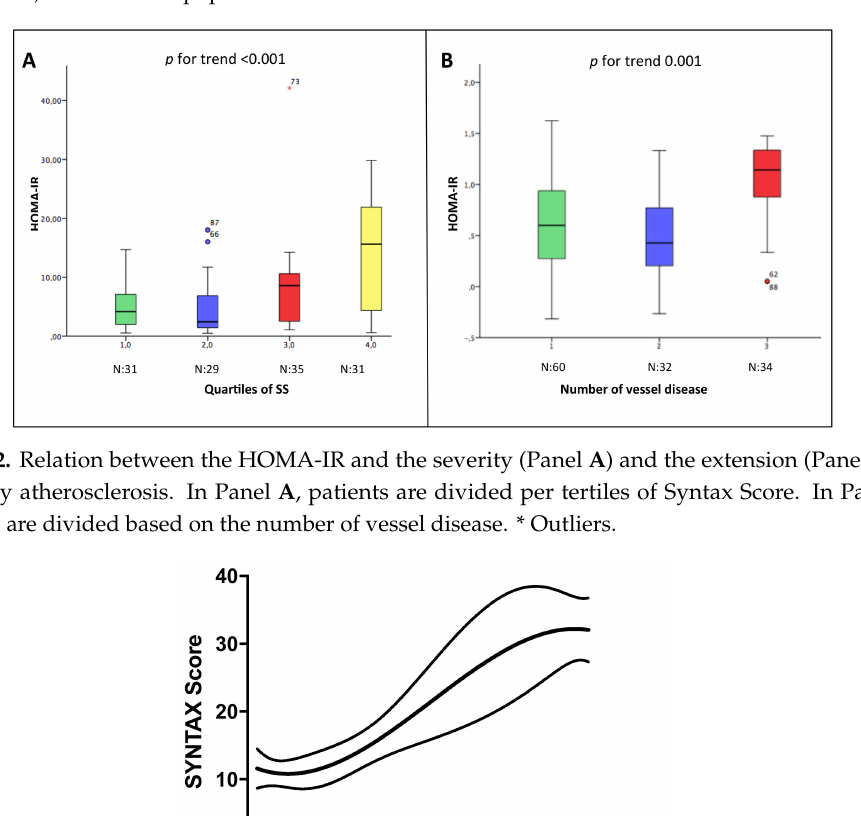
Figure 1. Correlation between syntax score and homeostasis model assessment of insulin resistance (HOMA-IR) in the overall population.